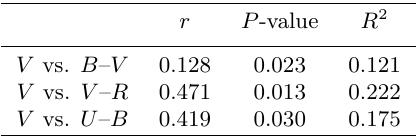
Fig. 5. Correlations between the long-term V light curve and color curves. Table 3. The correlation coefficients between the brightness and color obtained using a multiple regression